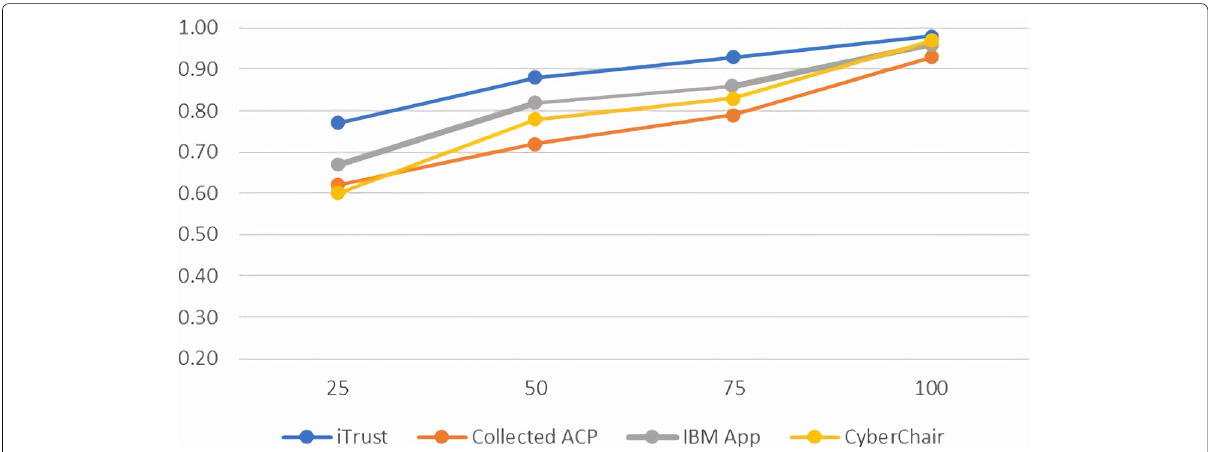
Fig. 10 Scalability test results of the subject-attribute relation.The x-axis indicates the percentage of data used during the experiment while the y-axis shows the performance using the F 1